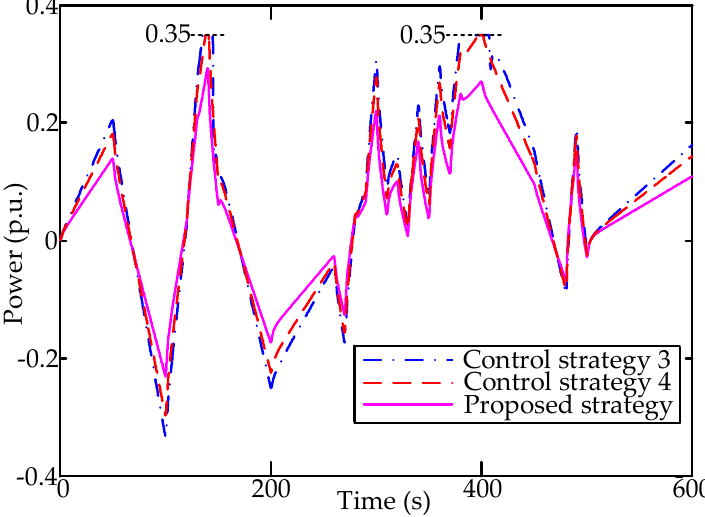
Figure 14. The power output of regulation generators under different control schemes.